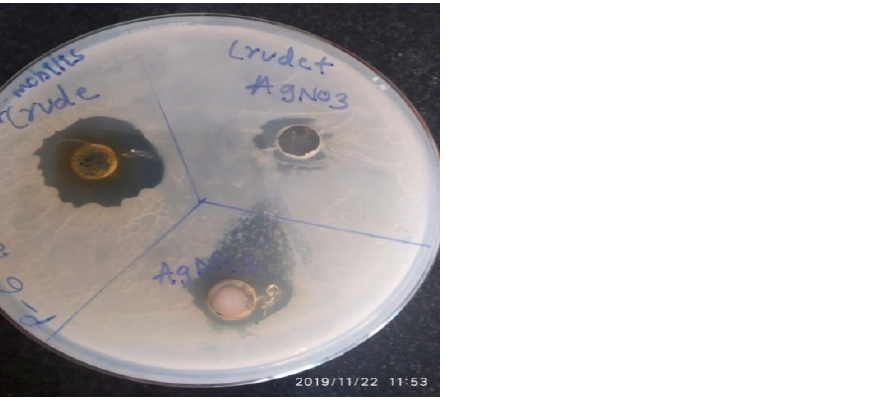
Figure 6. Antimicrobial activity of synthesized nanoparticles by A. concinna extract against Z. mobilis.